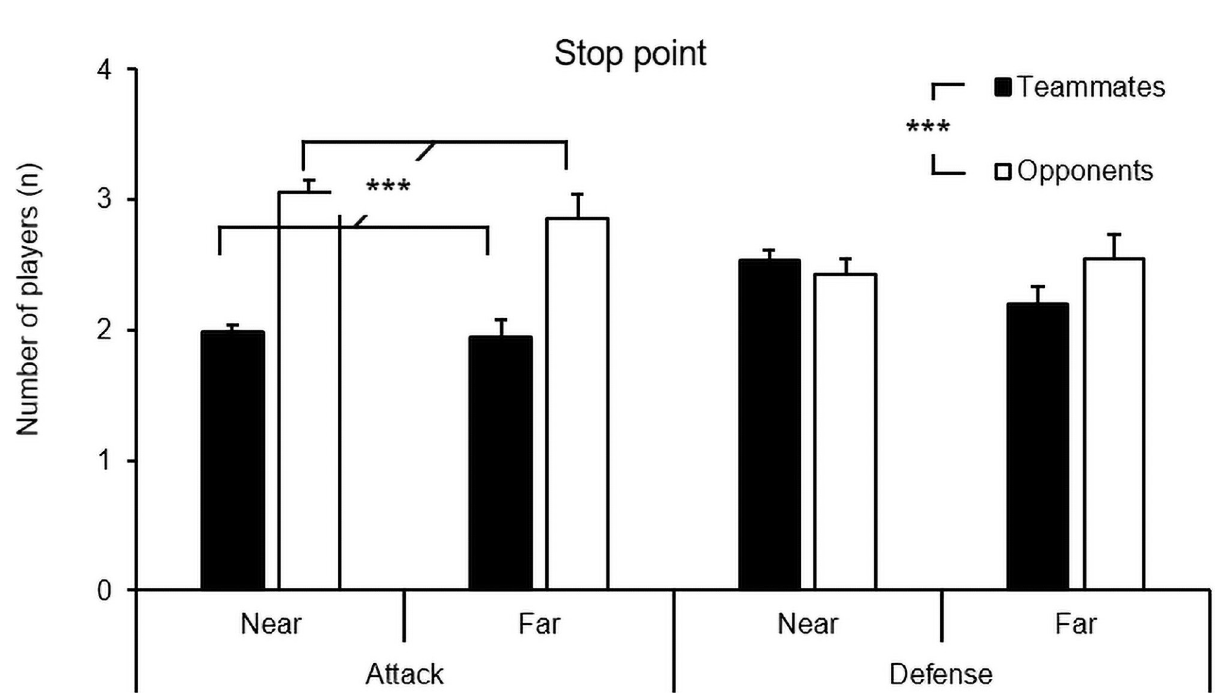
Fig 8. Means and standard errors of the number of teammates and opponents within the entire video frame at the stop point of the scans as a function of the playing phase (attack, defense) and distance (near, far).